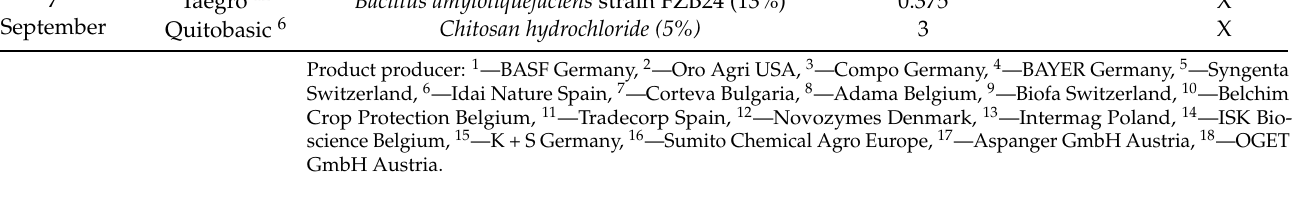
Table 4. Spray program for the Merlot vineyard in the 2022 season at integrated (IP) and 0-pesticide residue (ZPR) grape protection system. Preparation was applied if marked with